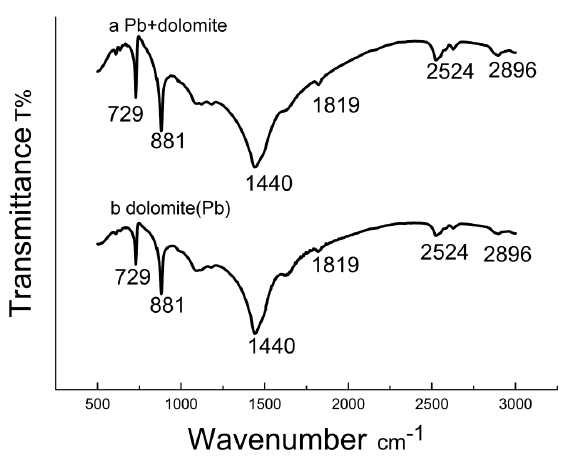
Figure 5. The two sets of mid-infrared spectra share the same peak distribution character- istics: two sharp peaks at 729 cm −1 and 881 cm −1 , a broader and stronger absorption band at 1440 cm −1 , and three smaller, weaker peaks in the high-frequency region, located at 1819 cm −1 , 2524 cm −1 , and 2896 cm −1 .